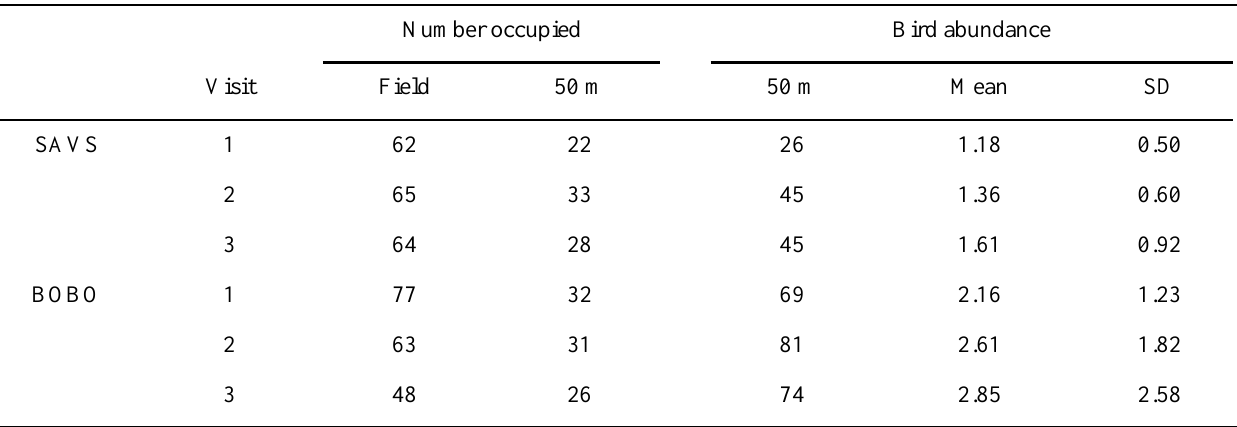
Table 2. Total number of occupied fields, total number of occupied 50-m sampling stations, and abundance of birds within occupied 50-m sampling stations by male Savannah Sparrows (SAVS) and male Bobolinks (BOBO) on point counts conducted in the Champlain Valley, May 21 to July 2, 2002. The columns for Mean and SD refer to the number of birds per count within 50 m of the sampling station on counts that contained at least one Savannah Sparrow or Bobolink. Notice that the density of SAVS and BOBO in occupied sites increases on each successive